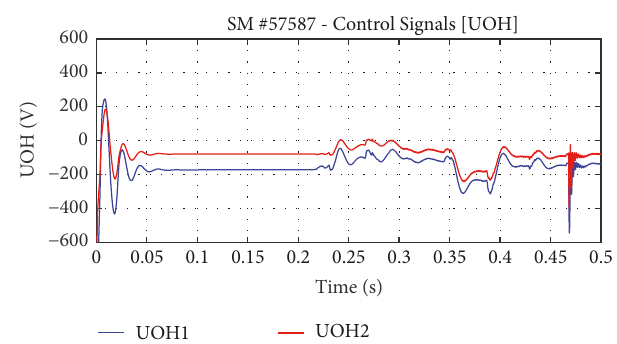
Figure 18: Sliding mode control signal (Shot